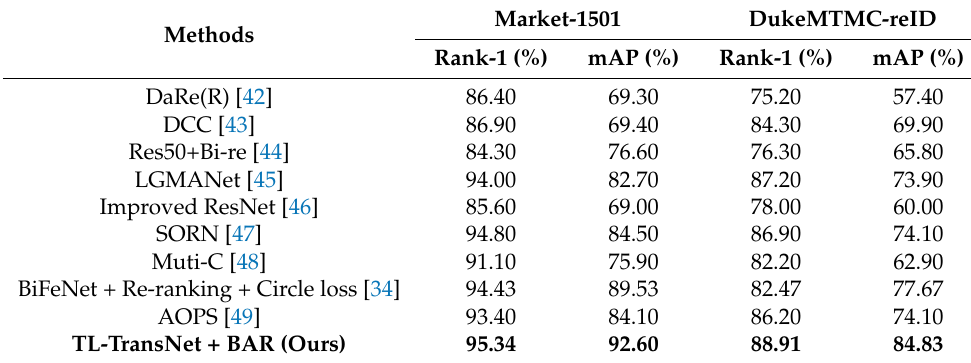
Table 6. Comparison with the state-of-the-art